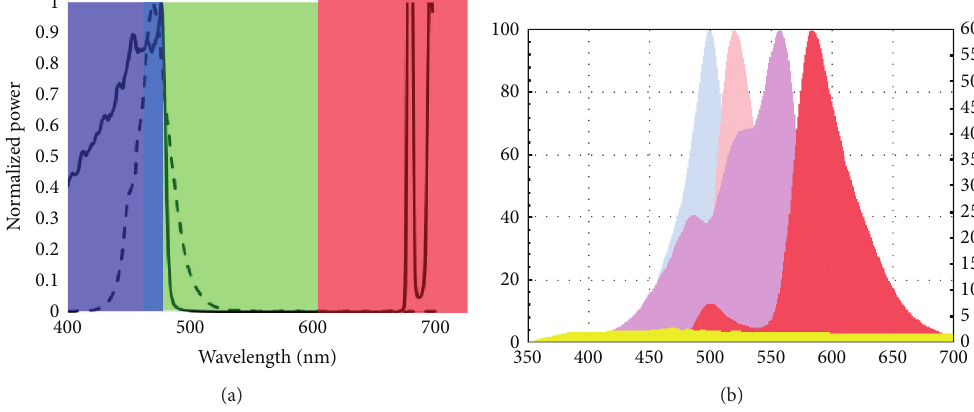
Figure 4: (a) The spectrum of two possible light sources for fluorescence guided surgery. The solid line illustrates the spectrum of a filtered Xenon lamp as used in Tran Cao et al. [1]. The dash line illustrates a typical blue LED spectrum. The color blocks mark the spectral range of red, green, and blue channels on common RGB CCDs. (b) Overlapping emission and excitation spectra of GFP/Alexa-488 and RFP/Alexa- 555 fluorescent proteins and fluorophores. Blue and salmon color peaks represent the excitation and emission spectra of GFP/Alexa 488, respectively. Pink and Red peaks represent excitation and emission spectra of RFP/Alexa 555, respectively. This graphic demonstrates the utility of the overlapping spectra of these fluorophores in the spectral range of GFP in detecting tumor while maintaining adequate visualization of surrounding structures for spatial orientation and surgical navigation. Filtering an LED light source through a 495 glass filter creates the bandwidth by which tumors of different fluorescent colors are visualized simultaneously [3].